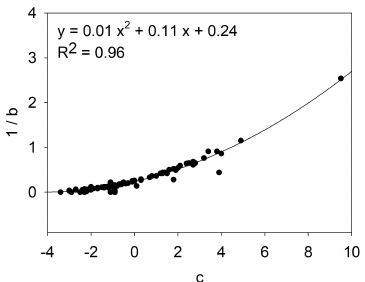
Figure 7. Relationships between 1 /b and c at the monthly